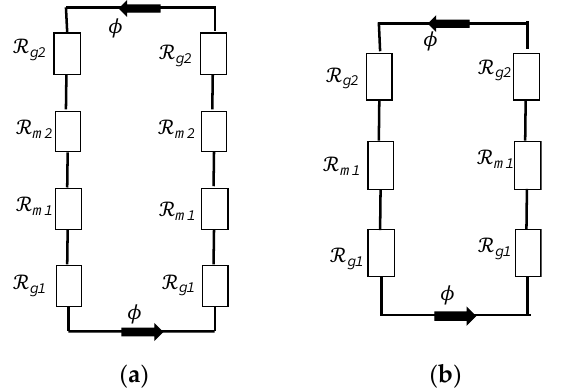
Figure 3. Flux path for DARF-PMVM: ( a ) with iron yoke rotor, ( b ) without iron yoke (yokeless) rotor.